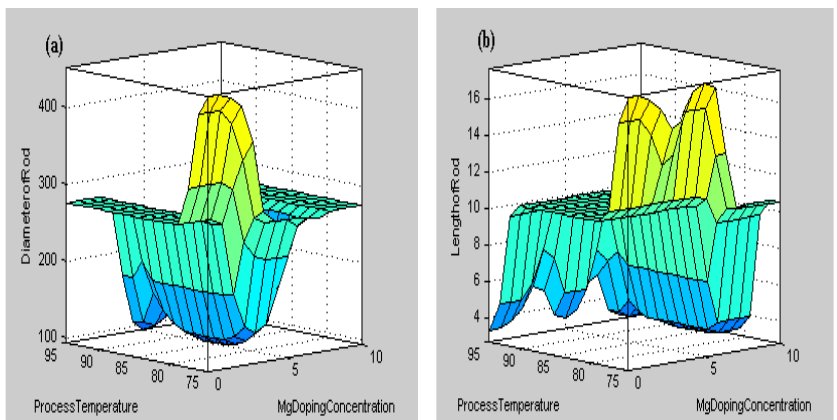
Fig. 4. 3D Graphs between (a) Process Temperature and Mg Doping Concentration with the Diameter of Rod as Output (b) Process Temperature and Mg Doping Concentration with Length of Rod as